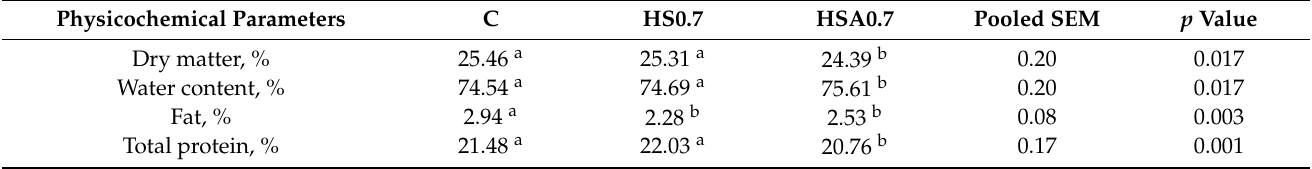
Table 4. The results of the physicochemical analyses of breast meat